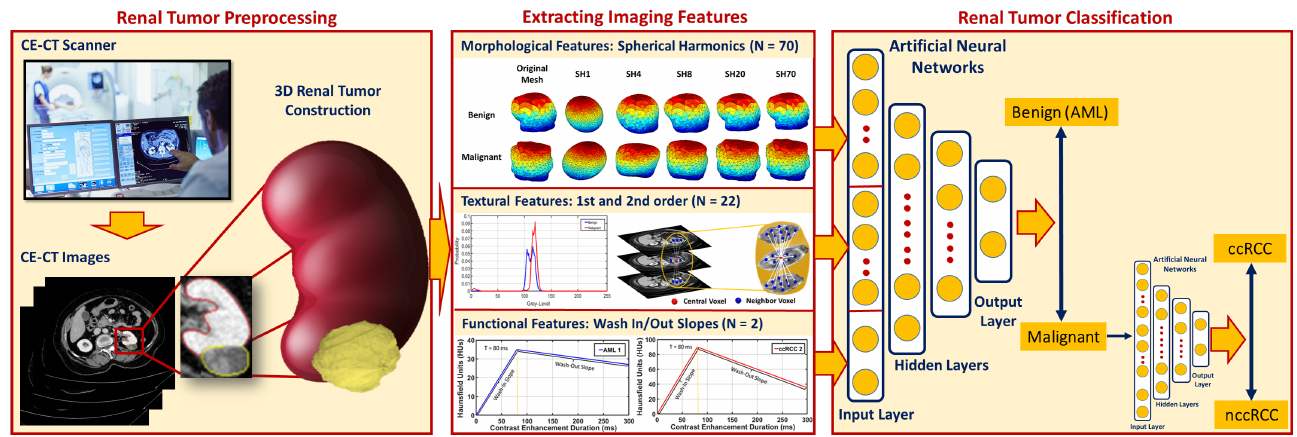
Figure 1. The proposed renal cancer computer-assisted diagnosis (RC-CAD)